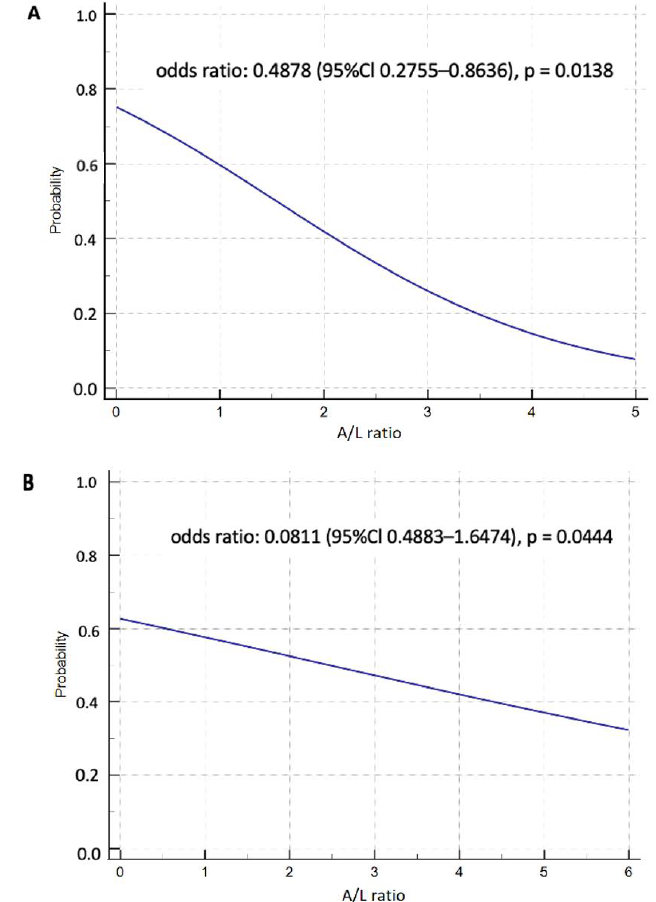
Figure 4. The risk of developing prediabetes and PTDM depending on the A/L ratio ( A ): baseline, ( B ): 1 year after KT. A/L — adiponectin/leptin.